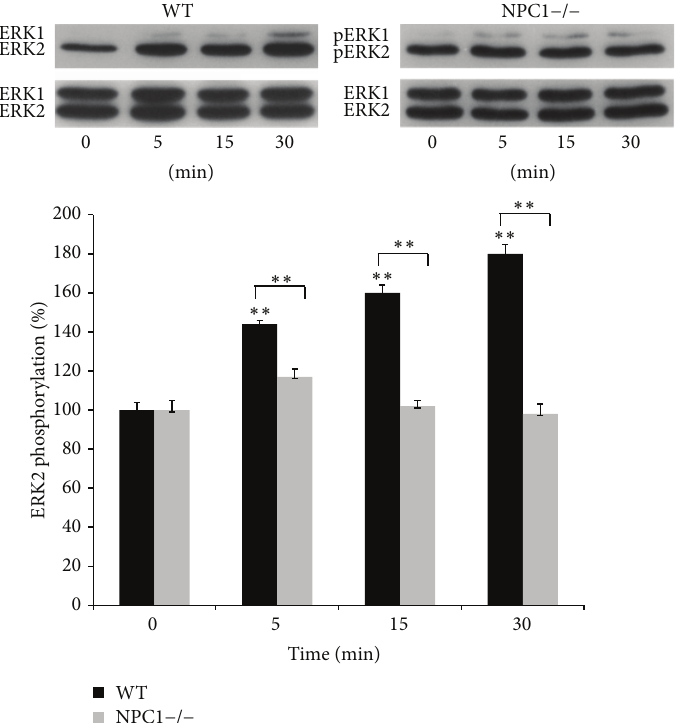
Figure 3: Time-course analysis of phosphorylation changes of ERK1/2 during LTP in WT and NPC1 − / − mice. Representative Western Blots of phosphorylated and total form of ERKs are shown in the upper panels. Densitometric quantitation of the immunoreactive bands at different times after LTP induction is illustrated in the lower panel. Values represent the normalized percent changes in ERK2 protein phosphorylation for each time point after LTP. Bars in the plots represent means ± SEM ( 𝑛 = 6 for WT mice, ∗∗ 𝑝 < 0.01 versus control values ( T 0); 𝑛 = 6 for NPC1 − / − mice, ∗∗ 𝑝 < 0.01 versus WT mice at the corresponding time